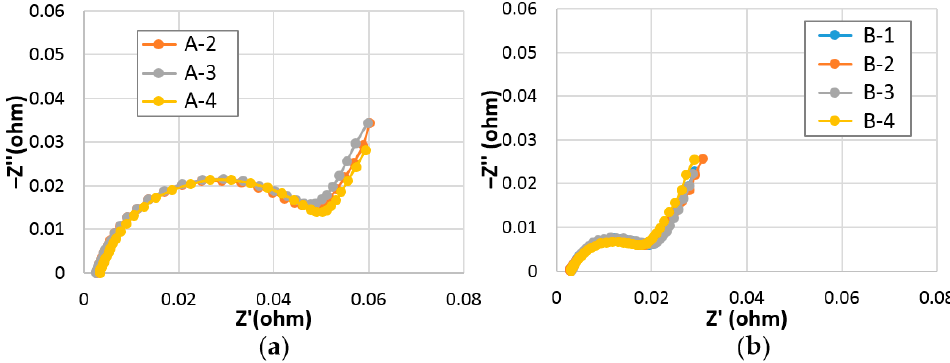
Figure 10. Cole–Cole plots of ( a ) cell A (set of three), and ( b ) cell B (set of four) measured at − 10 °C.